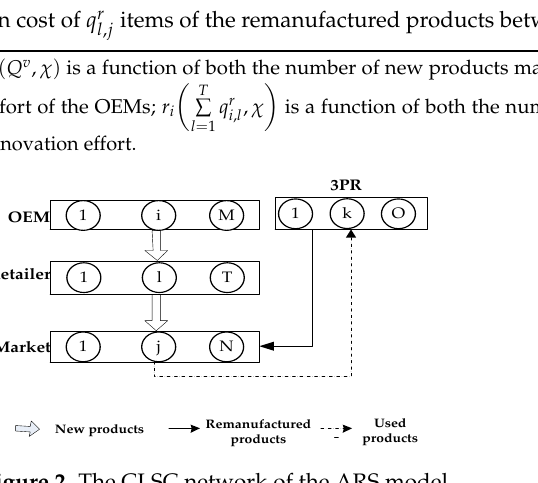
Figure 2. The CLSC network of the ARS model. Table 5. The decision variables, parameters, and cost functions in the ARS model.